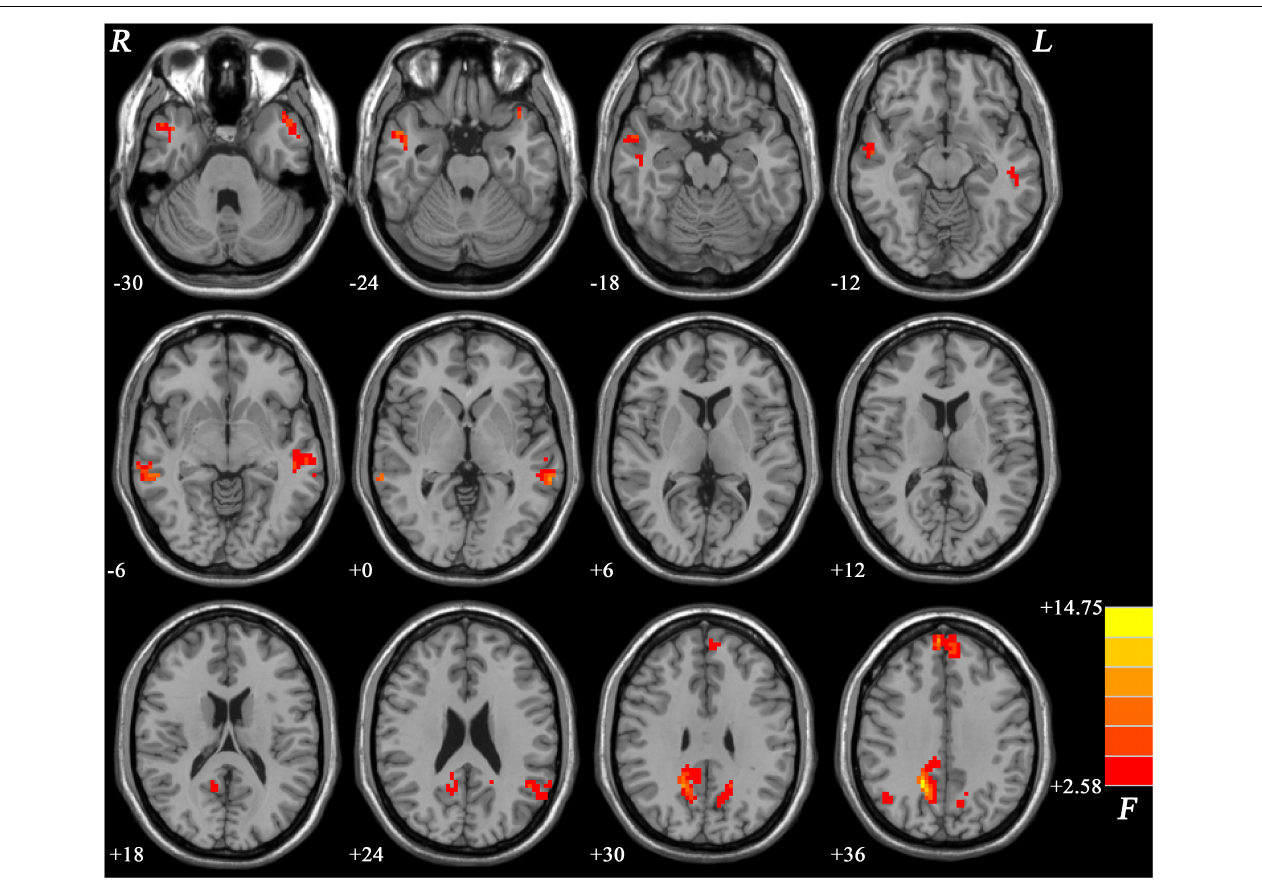
FIGURE 1 | Brain regions within the DMN showing group differences in NH values across the three groups. Color bar indicates F values from ANCOVA (age, sex, years of education, and frame-wise displacement as covariates). NH, network homogeneity; DMN, default mode network; ANCOVA, analysis of covariance.